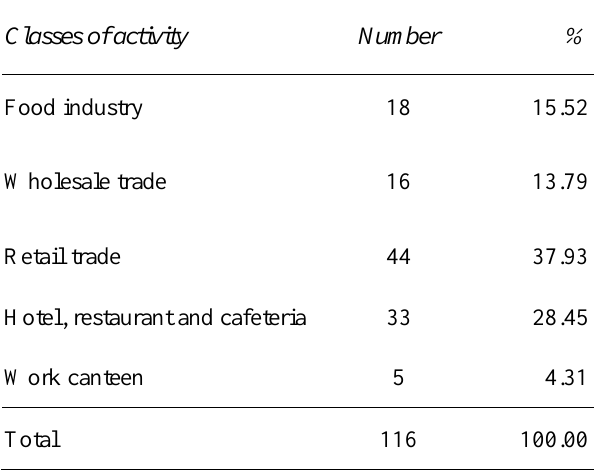
Table 1 indicates the distribution of the companies per activity class, whose self-monitoring plans were evaluated. Based on the evidence of the application of the evaluation sheet, the errors were classified as general and specific. The general errors were linked with three types: terminology, voluminosity and redundancy. Table 1: Food companies examined, for classes of